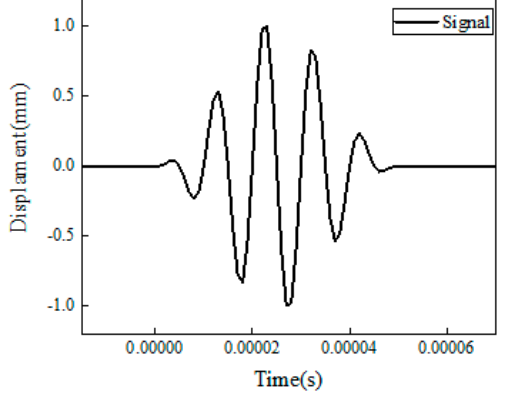
( b ) Figure 2. Phase velocity and group velocity. ( a ) Phase velocity. ( b )Group velocity 2.2. Calibration of the FE Simulation This section attempted to calibrate the FE model and quantify its effectiveness to cap- ture characteristics of guided waves propagating along a structure. A three-dimensional pipe was established in COMSOL which is commercial finite element (FE) software. The prototype was a 2000.0 mm long steel pipe according to the literature [44], with the outside diameter of 76.0 mm and the inner diameter of 68.0 mm. Two notch-shaped damages were located symmetrically at 1400.0 mm away from the left side. The dimensions of the defects were 2.0 mm in axial width, 3.0 mm depth and 35.0 mm in circumferential length. The material density was 7850.0 kg/m 3 , Youngs’ modulus was 210 GPa, and Poisson’s ratio was 0.28. Free triangular elements available in COMSOL were used to mesh the pipe. To ensure the calculation accuracy and consider the computational efficiency, the maximum element size was 5.0 mm, and the minimum element size was 2.0 mm. In addition, the maximum time increment should be less than 1/20 of the excitation frequency [45]; thus,